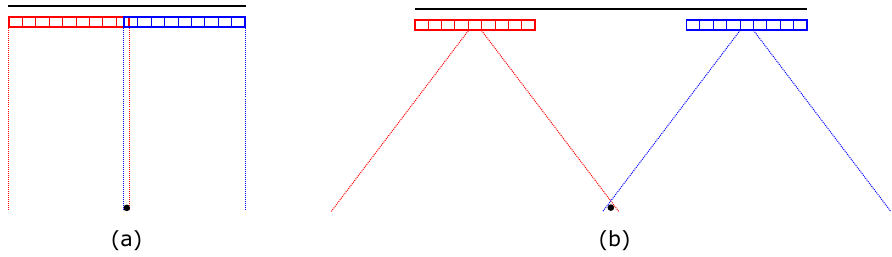
Figure 1. Illustration of the transmit geometries used for correlation-based SSA imaging showing two array positions imaging a target (black circle). Black lines above the array show the synthetic receive array length. ( a ) Plane wave transmission produces highly correlated echoes for motion tracking but limits spatial overlap and does not produce an improved synthetic transmit aperture. ( b ) Diverging wave transmission produces long effective transmit and receive arrays for high resolution due to large spatial overlap at depth but has low echo correlation for motion